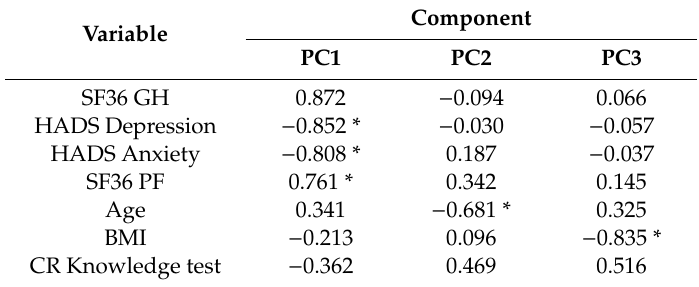
Table 3. Variable loading matrix and explained variance related to each PC after varimax rotation.